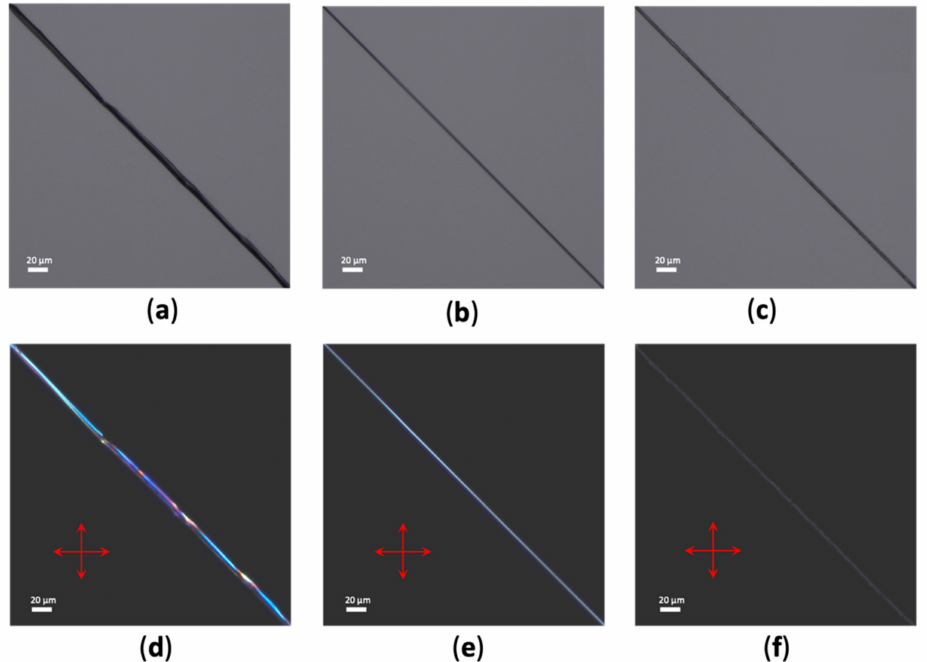
Figure 1. Representative light microscopy images of different fiber types were captured using the same settings. ( a ) Bright field image of a B. mori fiber. ( b ) Bright field image of a native dragline spider silk fiber derived from L. sclopetarius spider. ( c ) Bright field image of an NT2RepCT protein fiber. ( d ) POM image of a B. mori fiber. ( e ) POM image of a native spider dragline silk fiber derived from L. sclopetarius . ( f ) POM image of a NT2RepCT protein fiber. The orientation of the polarizers relative to the fiber is indicated by red double